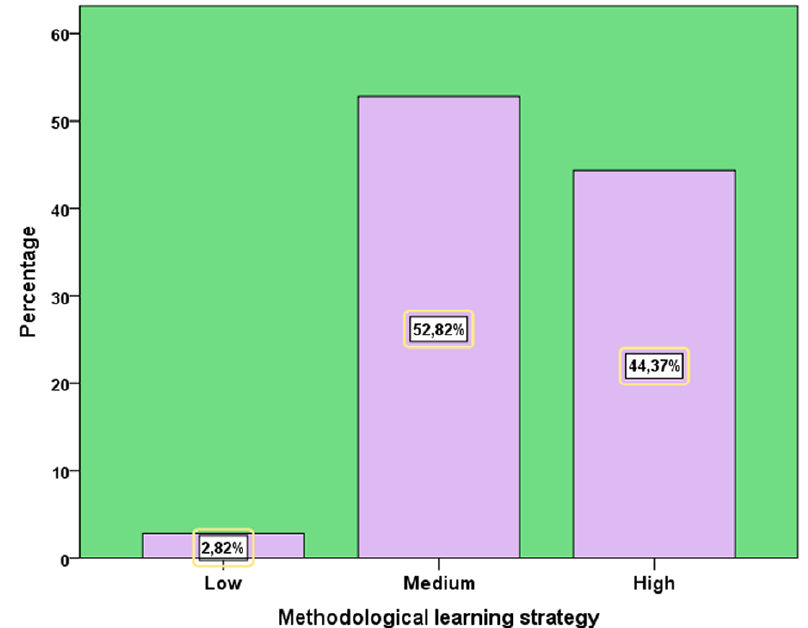
Fig. 4. Analysis of dimension 1: Methodological